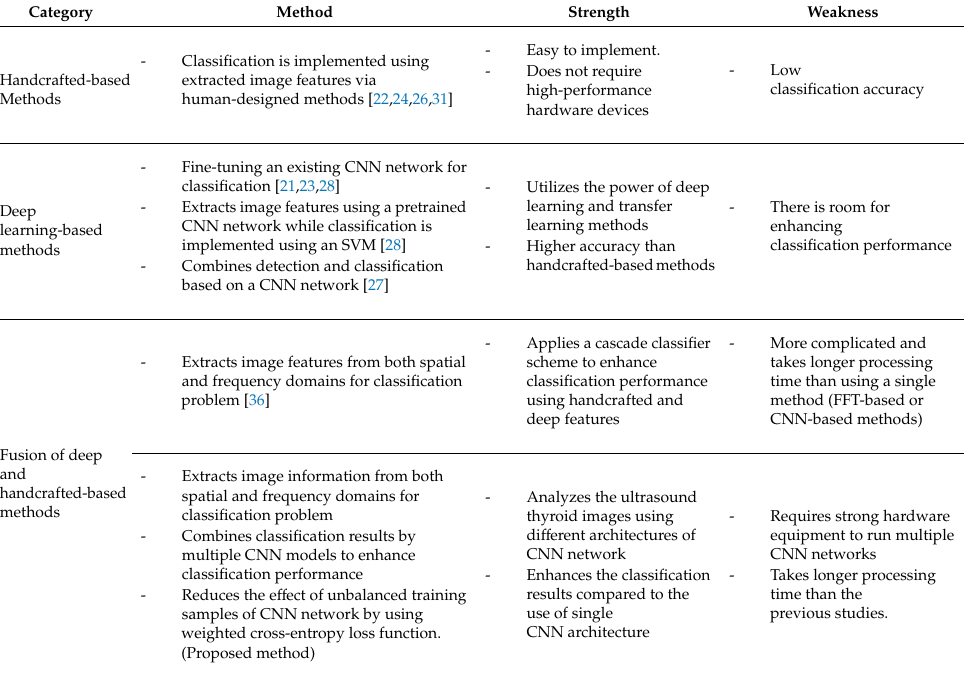
Table1. Summaryofthepreviousstudiesontheultrasoundthyroidnoduleimageclassificationproblem.